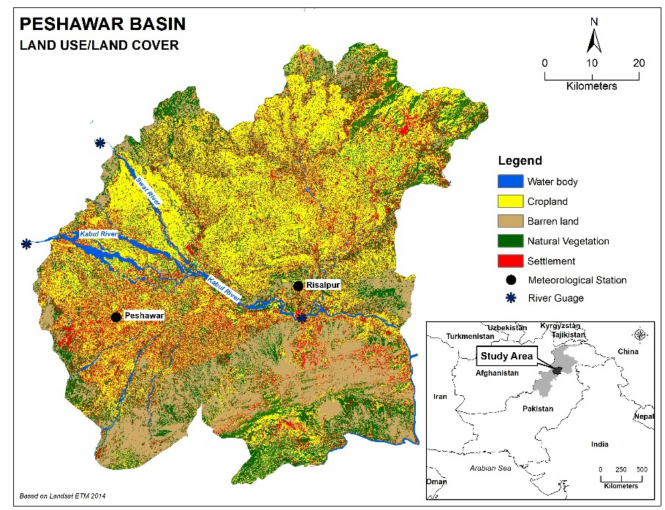
Figure 1. Land use and land cover map of Peshawar Basin, Pakistan.